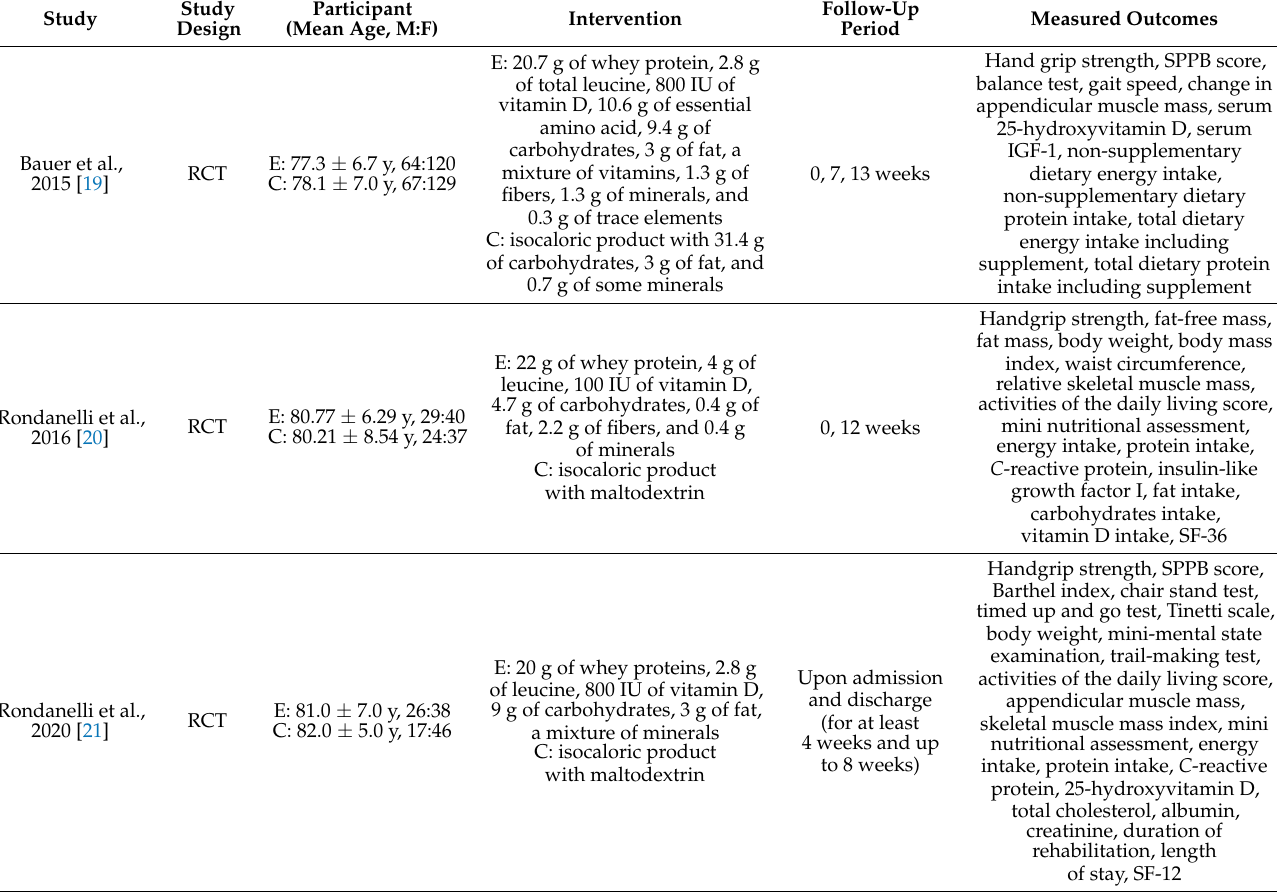
Table 1. Characteristics of selected